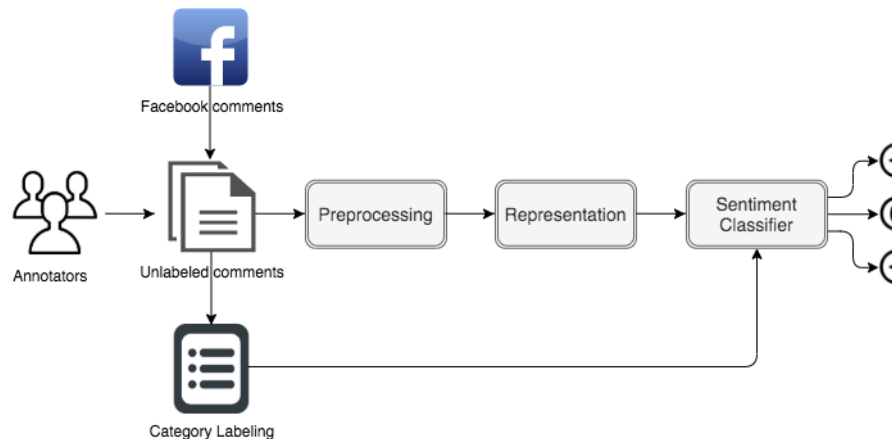
Figure 1. High-level architecture diagram of the proposed A LB A NA